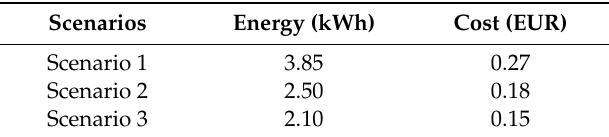
Figure 18. Comparison of the average daily energy consumption and cost management for a single user within three scenarios. Table 8. Comparison of the average daily energy consumption and cost management for single user within three scenarios.